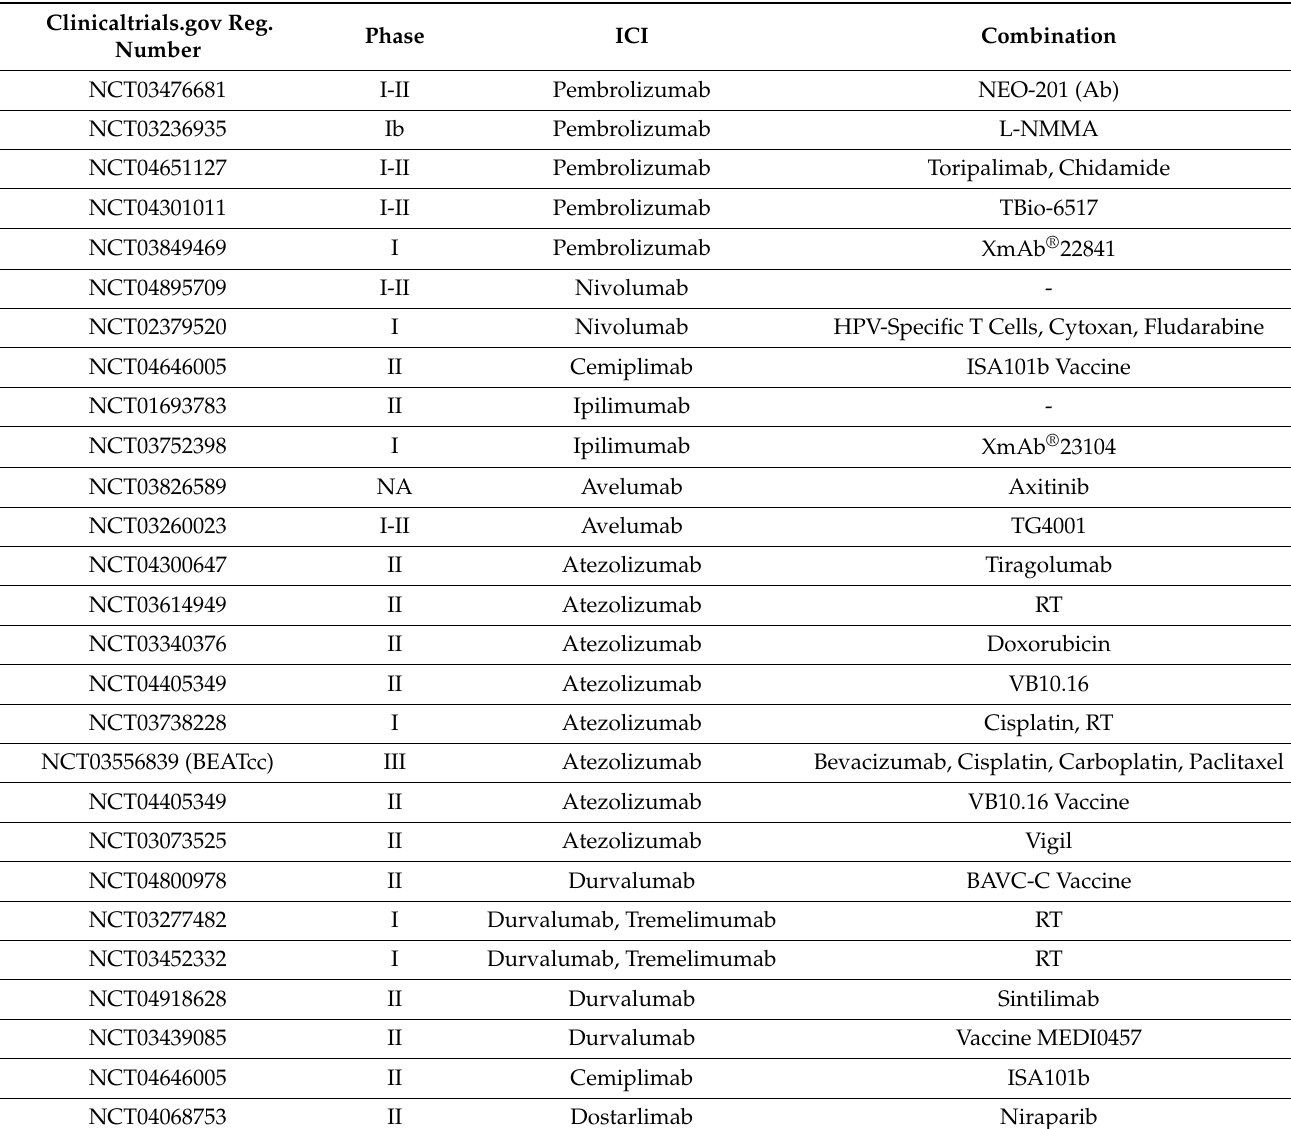
Clinicaltrials.gov